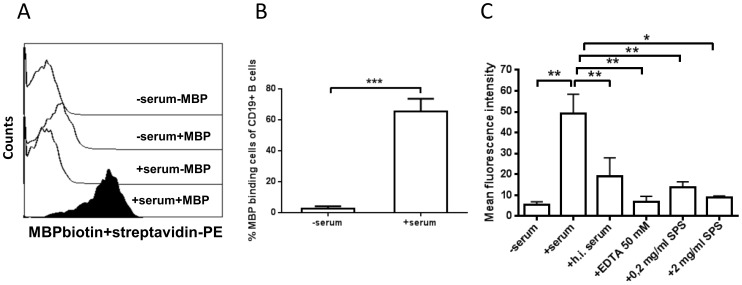
Serum complement promotes the binding of MBP to normal B cells.PBMCs from healthy donors were incubated for 30 min with or without 30 µg/ml biotinylated MBP in medium containing normal serum (30% v/v), or in pure medium. (A) Histogram plot depicting MFI values of MBP binding to B cells in one representative healthy donor. B) The binding of MBP to B cells from 7 healthy donors is shown, expressed as percentage MBP-positive B cells. C) Before addition to the culture media, serum was treated in one of three ways: heat-inactivated (h.i.) by heating to 56°C for 30 min, or supplemented with EDTA or sodium polyanethole sulphonate (SPS) in different concentrations. The resulting MFI values from 5–7 healthy donors are shown. Bars and error bars represent means and SEM *p<0.05 **p<0.01 and ***p<0.001.